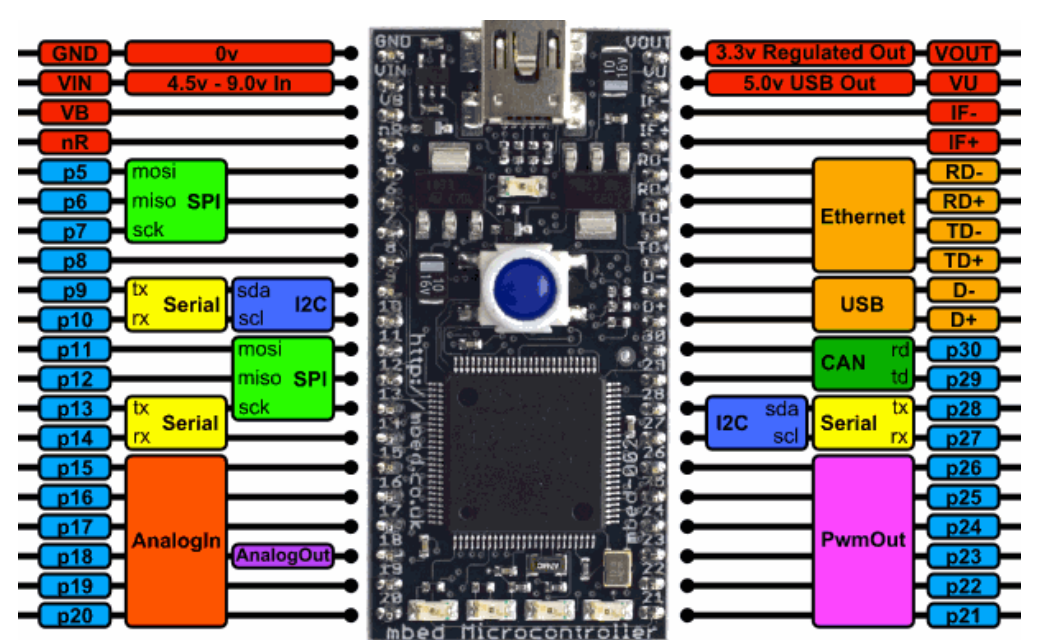
Figure 1. Mbed pinout